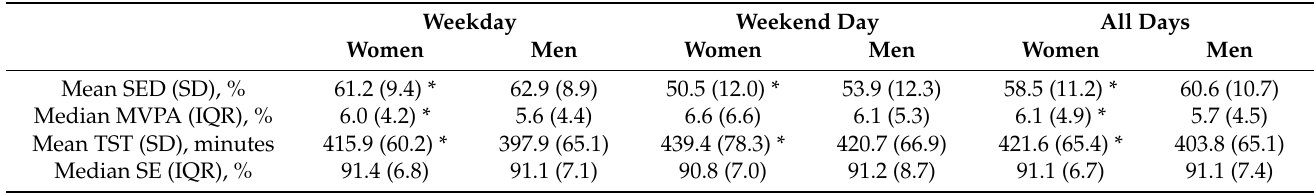
Table 2. Average or median proportion/minutes of wear time spent in physical activity and sedentary time, and sleep parameters.